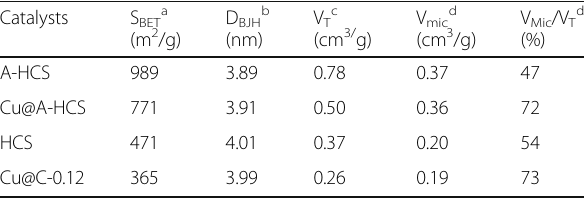
Table 3 Textural parameters of HCS, Cu@C, and activated